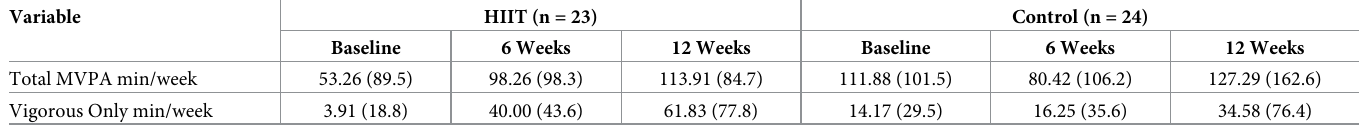
Table 4. The effect of the HIIT on physical activity: Unadjusted effects.